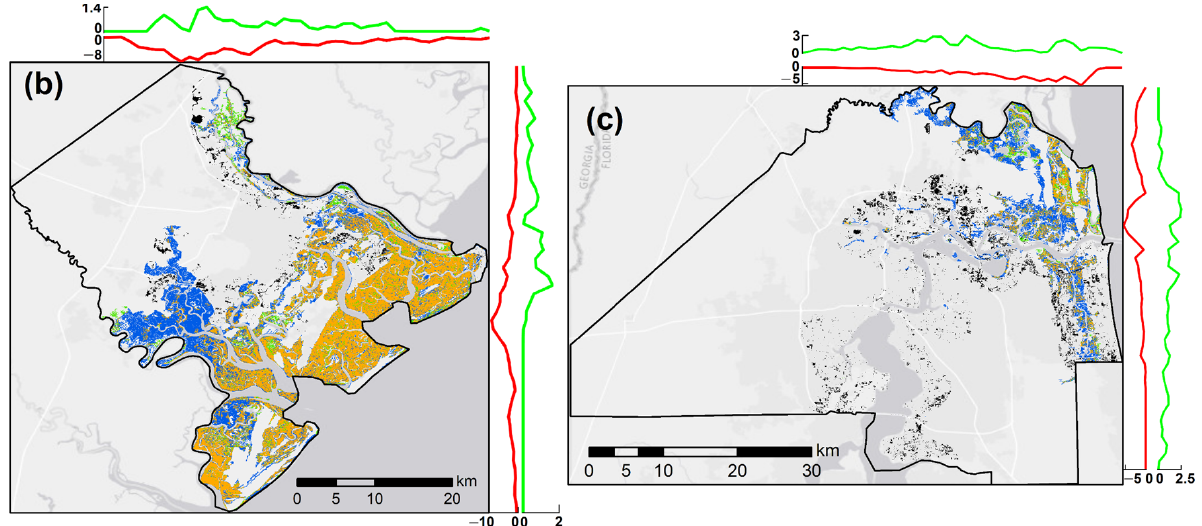
Figure 11. The spatial distribution of urban expansion and tidal flat dynamics from 1985 to 2015 within 2 km of the coast in ( a ) Charleston, SC, ( b ) Chatham, GA, and ( c ) Duval, FL. The area changes (in km 2 ) of tidal flats (in red) and urban extents (in green) are summarized as line charts along map edges. (The World Light Gray Basemap is used as the background, which is provided by Esri, HERE, Garmin, © OpenStreetMap contributors, and the GIS User